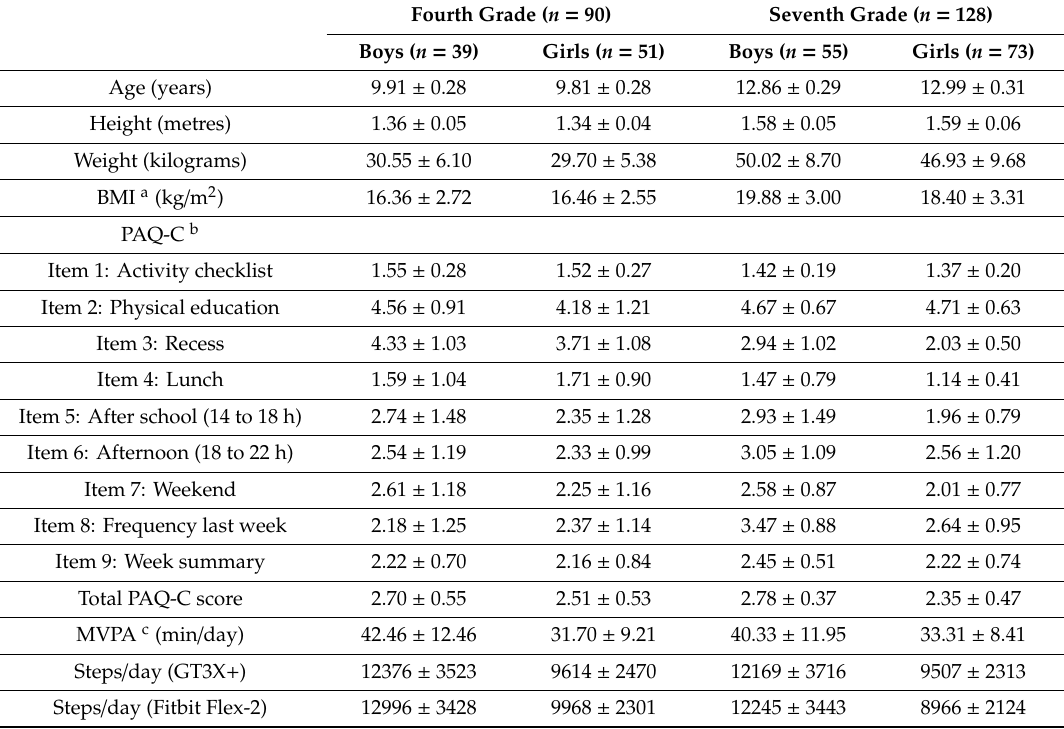
Table 1. Descriptive statistics of study participants by age group and gender.